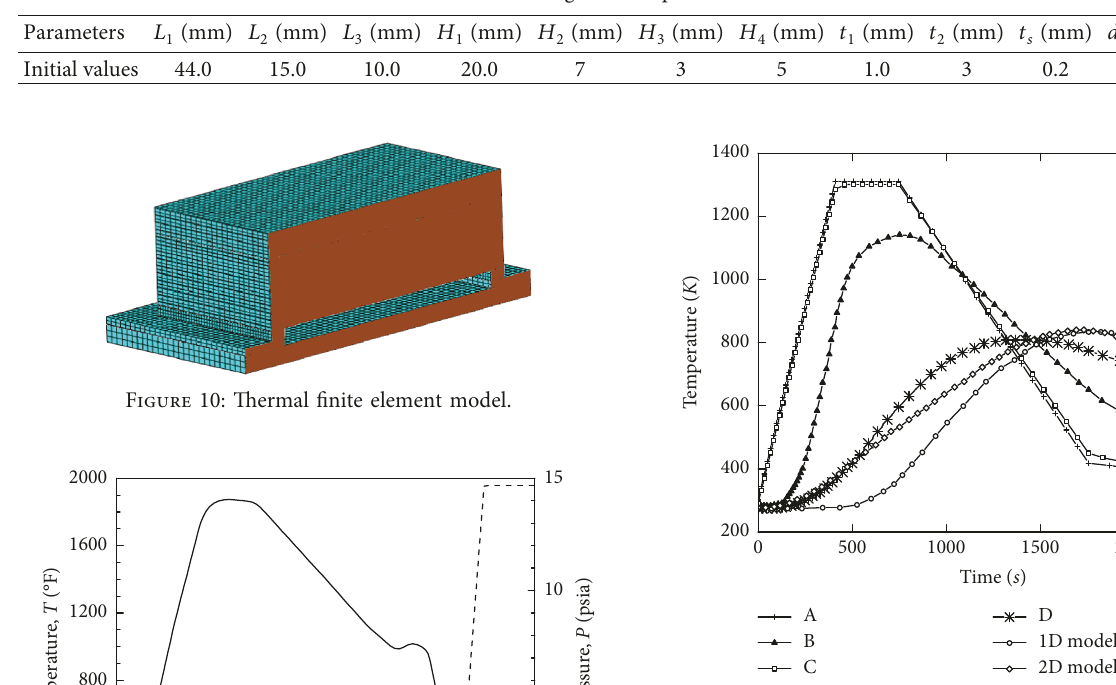
Figure 9: Geometry, load, and boundary condition for MTPS. Table 6: Initial geometric parameters for MTPS.